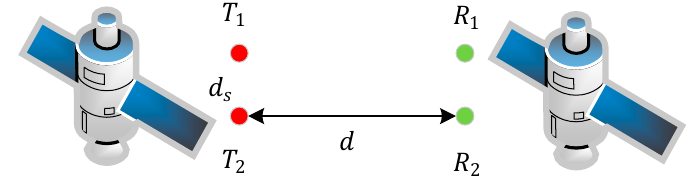
Figure 12. The 2 × 2 MIMO inter-satellite communication system.